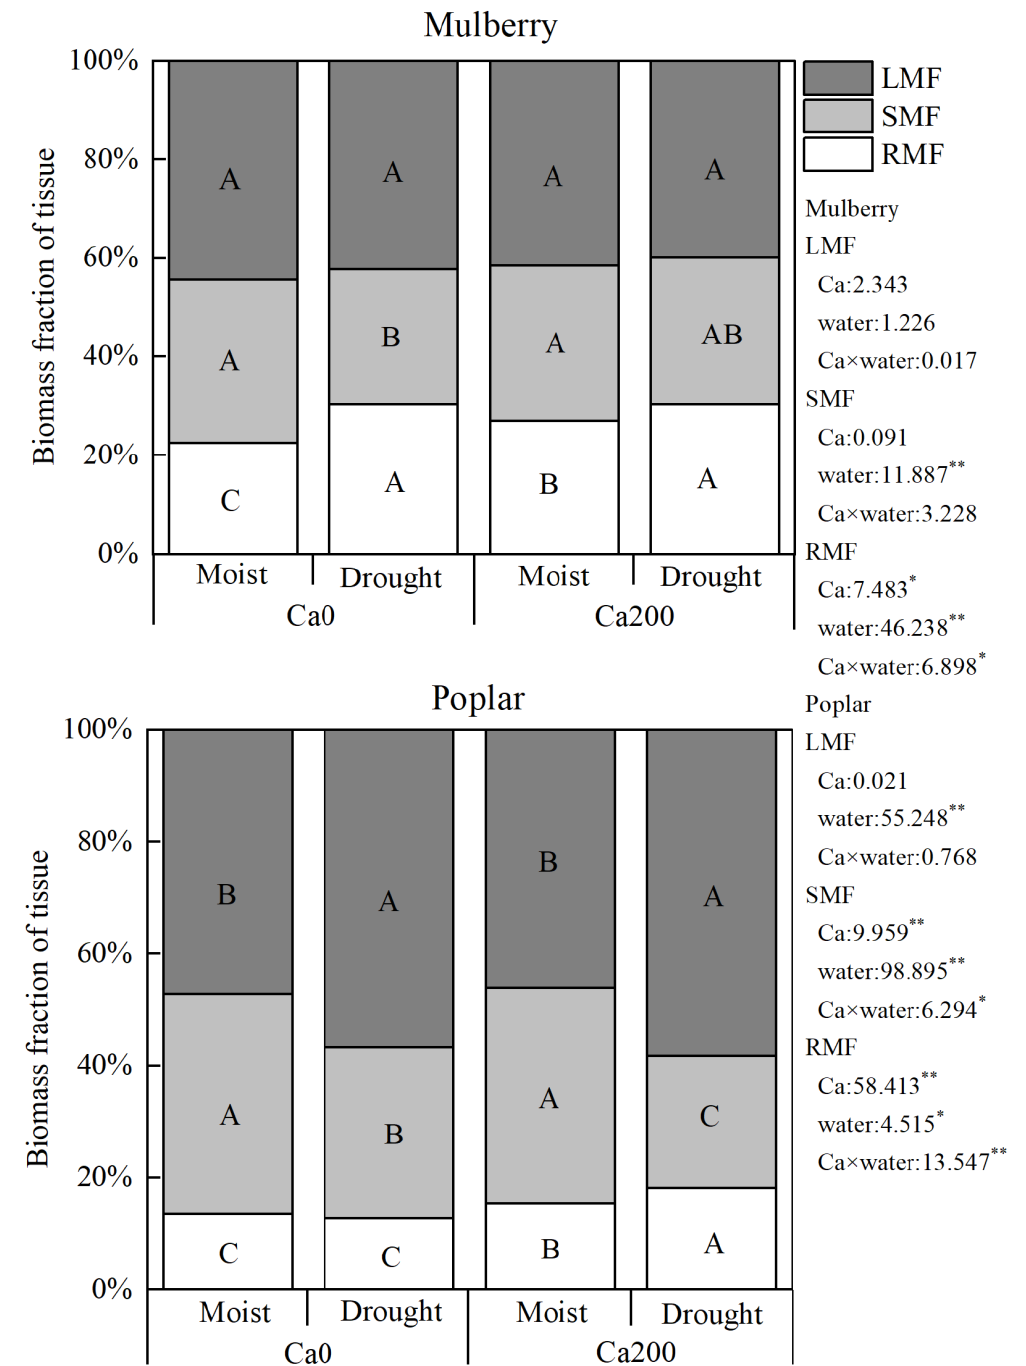
Figure 2. Effects of water and Ca treatments on biomass allocation in organs of the two species. Different letters indicate significant differences ( p < 0.05 ) among treatments. Treatment values shown as mean ± SE (n = 6). Results of two − way ANOVA addressing effects of Ca and water treatments are summarized on the right side. *, ** indicate that the F value is significant at p ≤ 0.05 and 0.01, respectively.